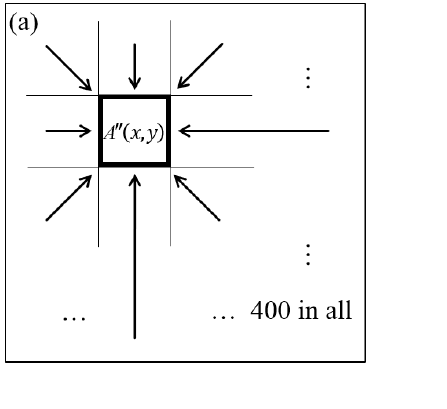
Figure 4. ( a ) Schematic diagram of mutual crosstalk between spots; ( b ) calibration curve of total power.